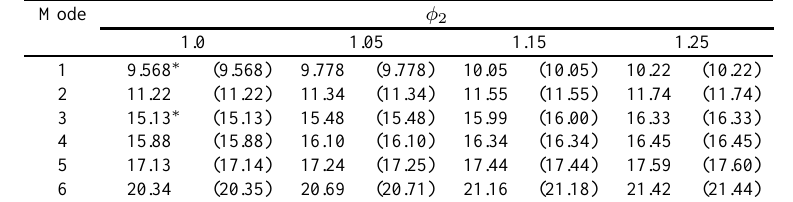
ison values obtained from Multi-Span Approach, in brackets ( ∗ indicates classical